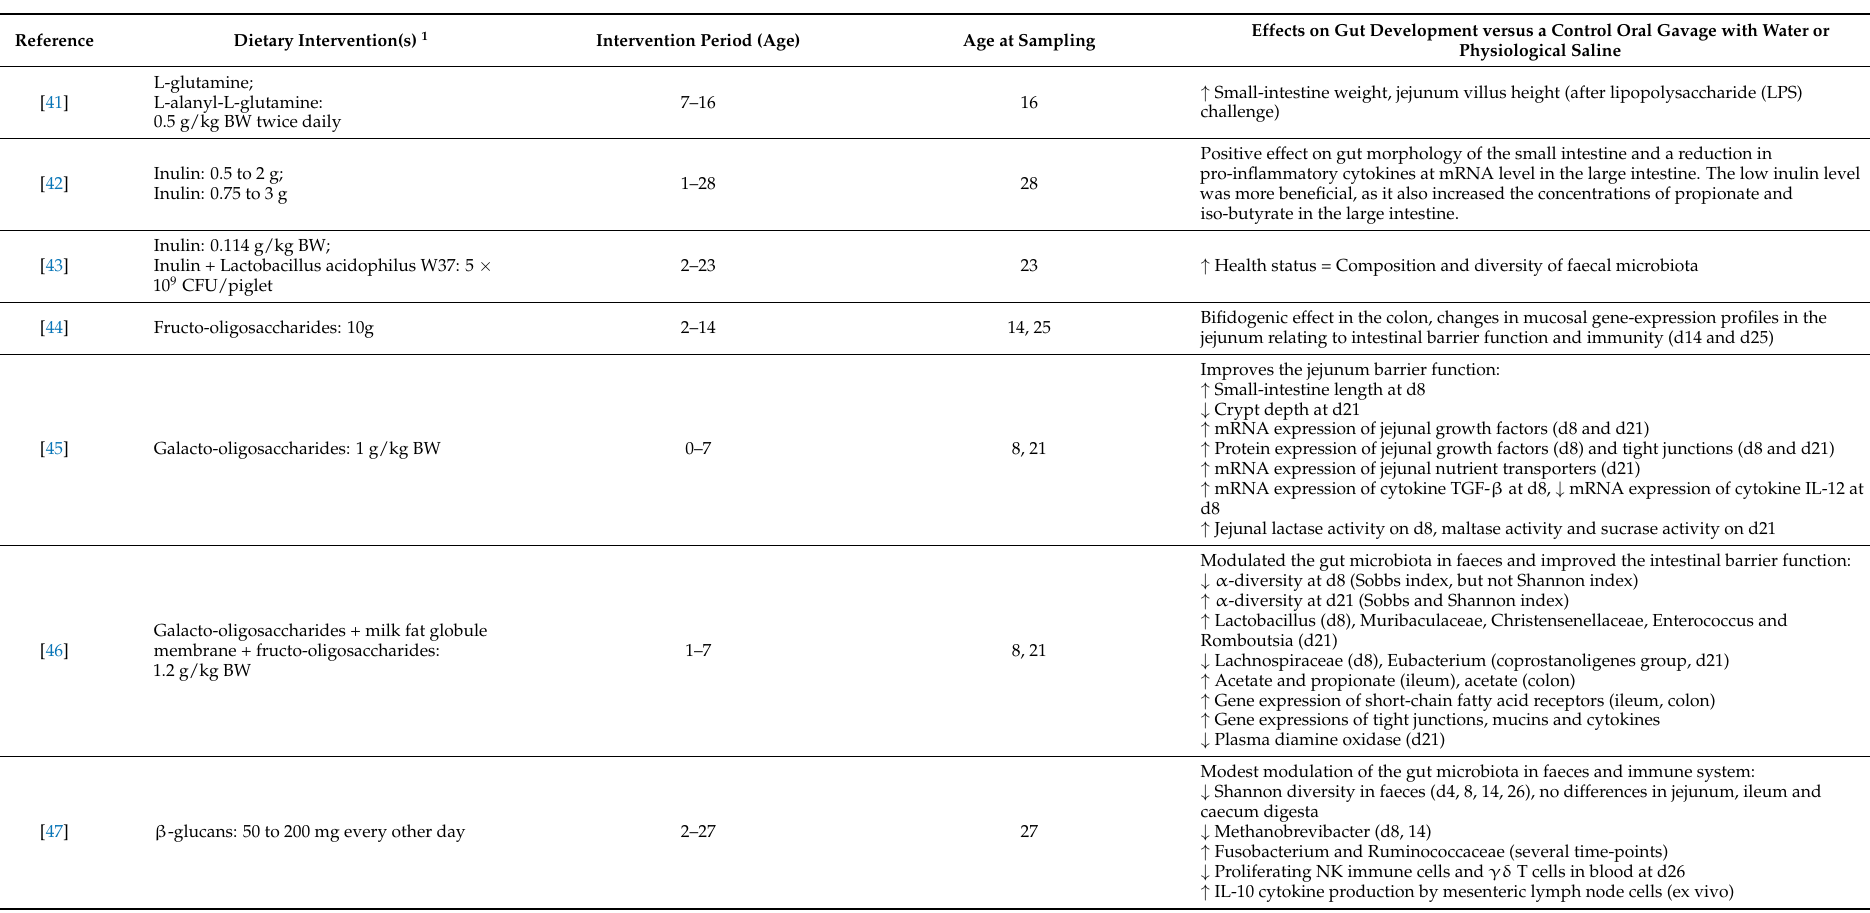
Table 1. Effects of pre-weaning dietary interventions through oral gavage on the gut development of sow-reared piglets. ↓ Significant decrease at p < 0.05; ↑ Significant increase at p < 0.05; = No significant difference; BW = body